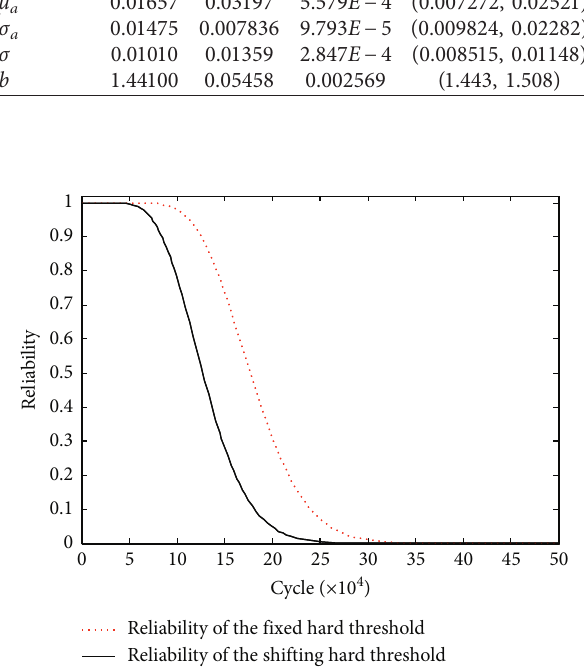
Figure 4: Reliability curves subject to hard failure.